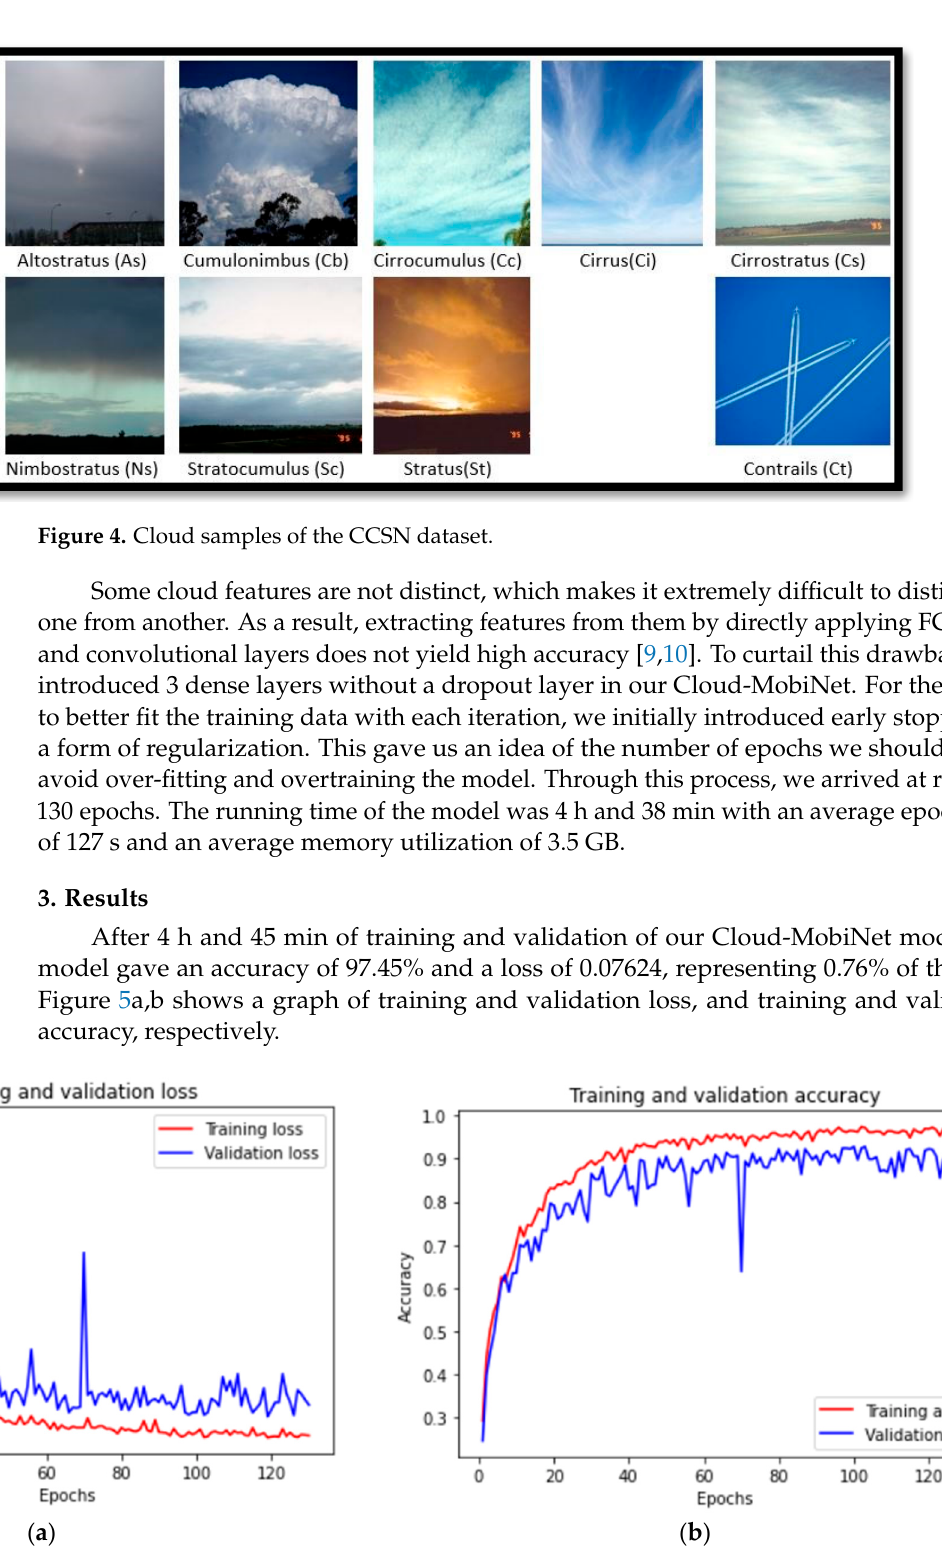
Figure 5. ( a , b ) The graph of training and validation loss, and training and validation accuracy, re-